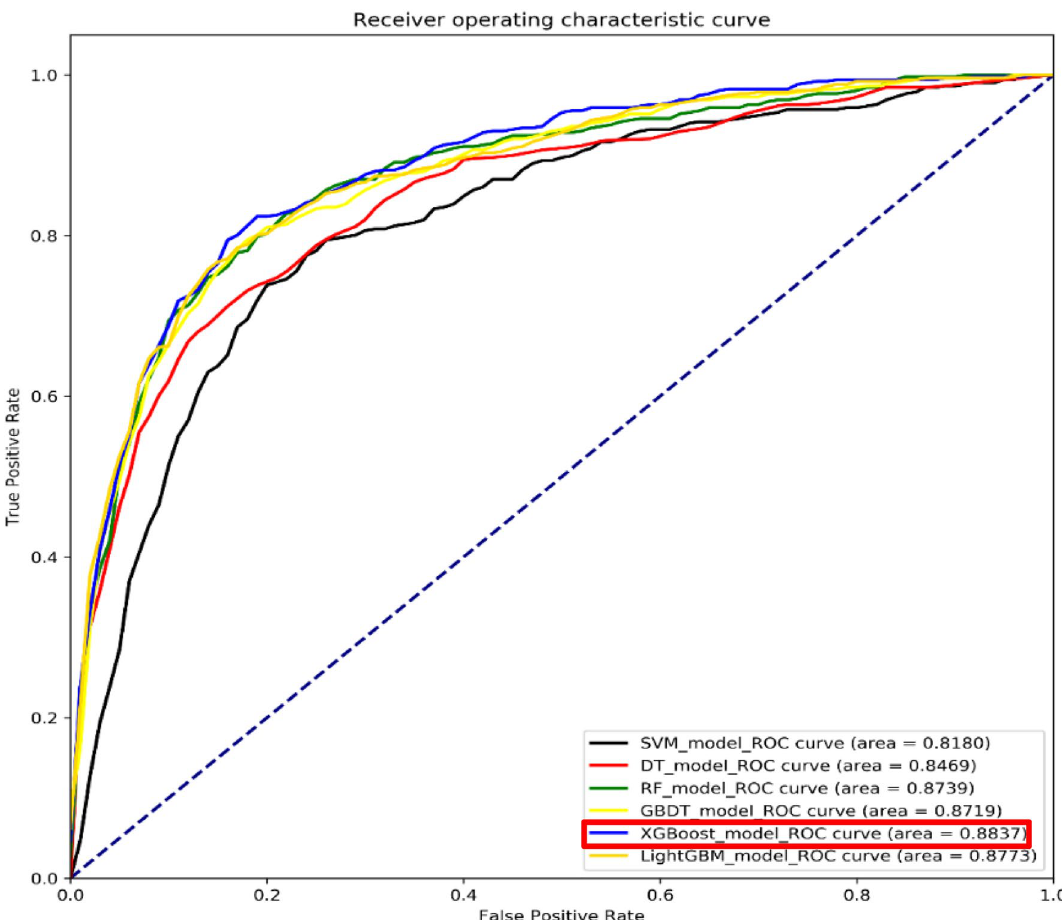
Figure 3. Comparison of prediction performance of six machine learning classification algorithms. The optimal model is XGBoost in the red box. The six algorithms include Gradient Boosting Decision Tree (GBDT), Extreme Gradient Boosting (Xg-boost), Random Forest, Light-GBM, Decision Tree, and Support Vector Machine (SVM). The ROC curve of GBDT is shown by the yellow line, the ROC curve of Xg-boost is shown by the blue line, the ROC curve of Random Forest is shown by the green line, the ROC curve of Light-GBM is shown by the orange line, the ROC curve of Decision Tree is shown by the red line, the ROC curve of SVM is shown by the black